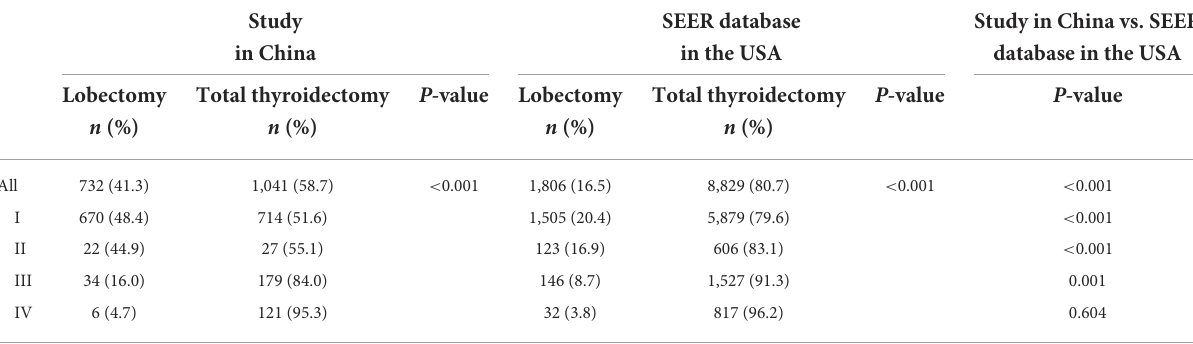
TABLE 6 Comparisons on extent of surgery of DTC patients between the study in China and SEER database in the USA. Study SEER database Study in China vs. SEER in China in the USA database in the USA Lobectomy Total thyroidectomy P- value